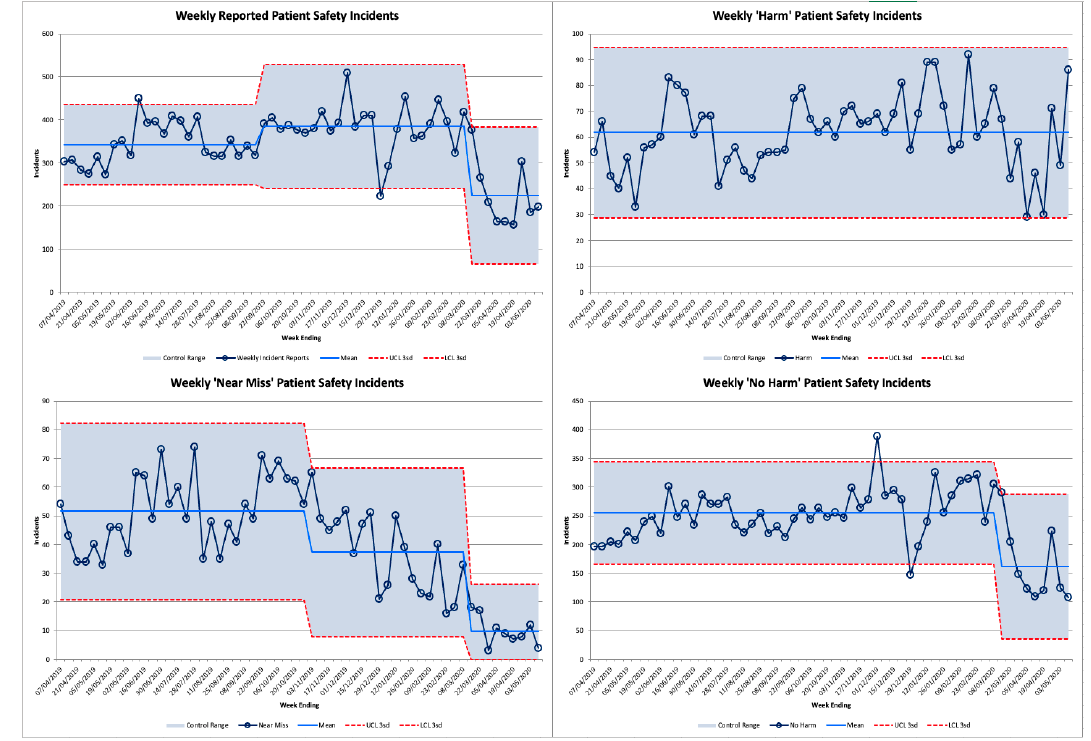
Figure 3. Incident Reporting Year to Date.